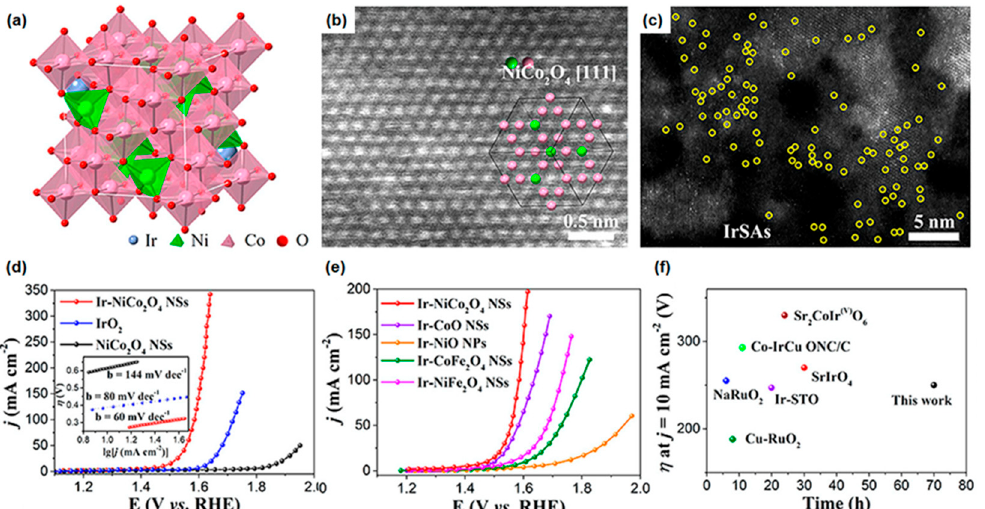
Figure 4. ( a ) Structural characterization of Ir-NiCo 2 O 4 NSs. ( b ) High-angle annular dark- fi eld scan- ning transmission electron microscope (HAADF-STEM) image of Ir-NiCo 2 O 4 NSs and ( c ) HAADF- STEM image of Ir-NiCo 2 O 4 NSs (Ir-SAs marked by yellow circles). ( d ) LSV curves of commercial IrO 2 , NiCo 2 O 4 , and Ir-NiCo 2 O 4 NSs in acidic medium (0.5 M H 2 SO 4 ). The inset in Figure 4d shows the corresponding Tafel plots. ( e ) LSV curves of Ir SAs on di ff erent oxides substrate for the OER in 0.5 M H 2 SO 4 . ( f ) Compared overpotential at j = 10 mA/cm 2 and stability of Ir-NiCo 2 O 4 NSs with previously reported OER catalysts in acid media. Reprinted (adapted) from [134], copyright (2023) American Chemical Society.